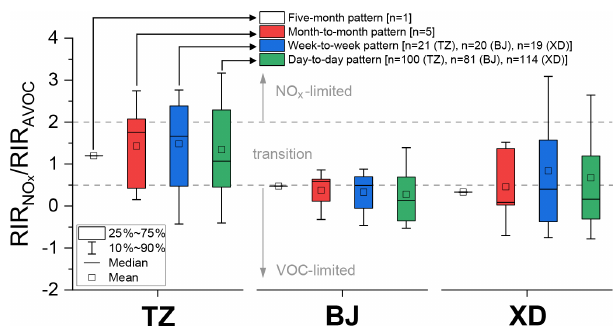
/ RIR AVOC (indicator of photo- x